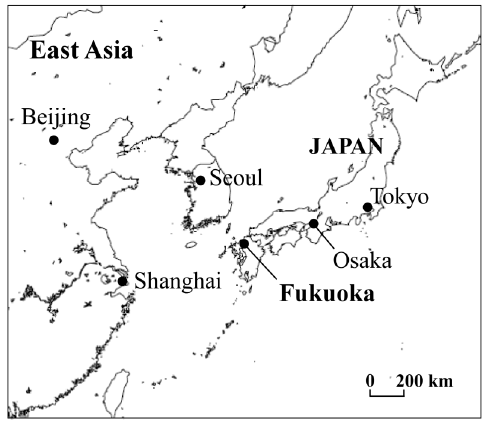
Figure 1. Location of Fukuoka City.